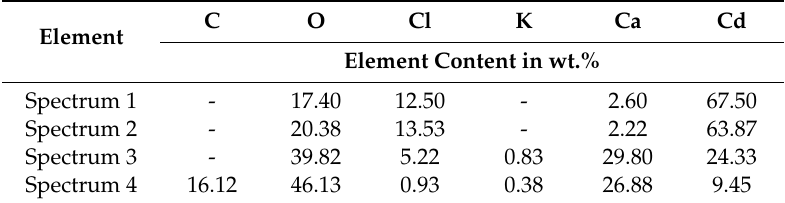
Figure 7. SEM micrograph ( a ) and EDX spectra ( b ) and ( c ) of sample CD3-6 (Table 1). Table 3. Element composition in wt.% of sample CD3-6.